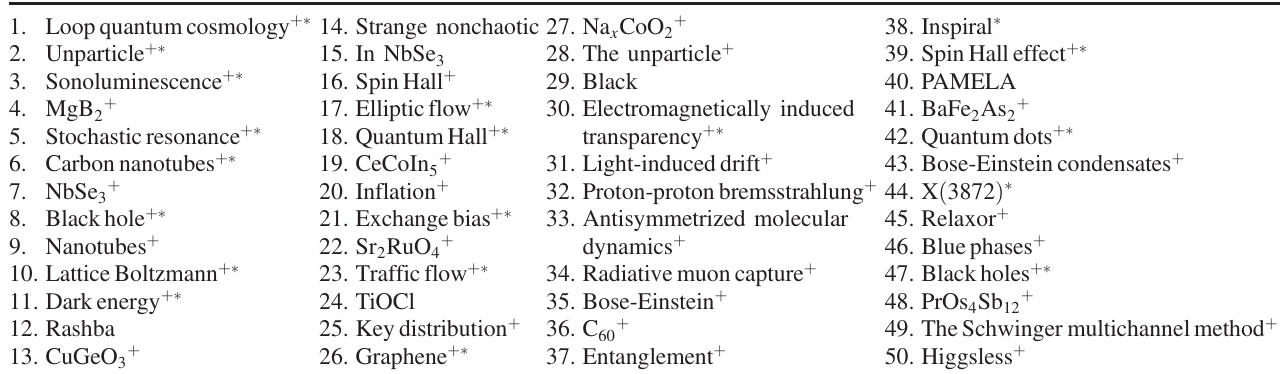
TABLE I. Top 50 memes with respect to their meme score from the APS data set. The symbol þ indicates memes where the human annotators agree that this is an interesting and important physics concept, while the symbol (cid:2) indicates memes that are also found on the list of memes extracted from Wikipedia (see Sec. IV for details).